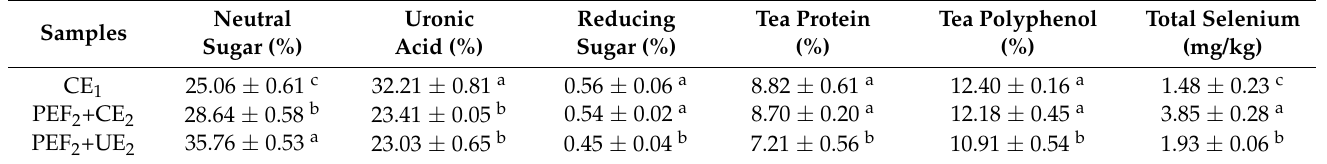
Table 1. Chemical compositions of Se − TPSs obtained using various extraction processes